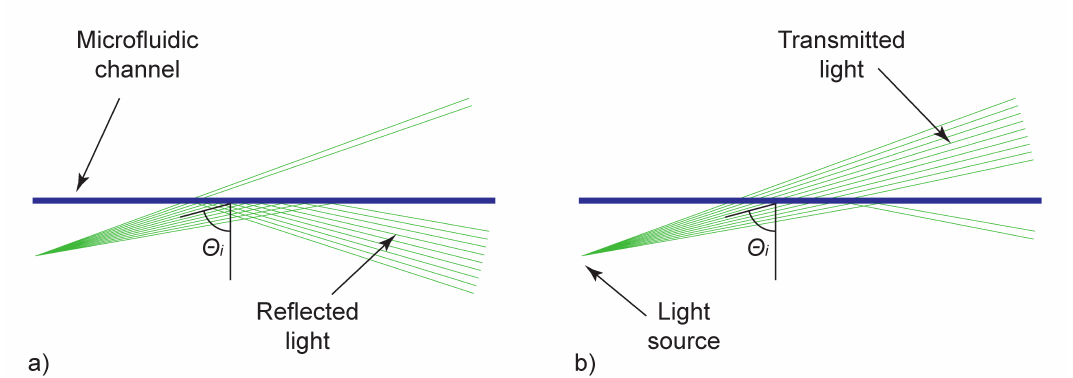
Figure 1. Schematic of the working principle. A straight microfluidic channel (blue line) is hit by slightly diverging laser light (green lines). ( a ) At samples having a low refractive index, most light rays are totally reflected, while ( b ) at samples with a high refractive index, most light rays are transmitted. The ratio of reflected to transmitted signal is used for sample characterization.